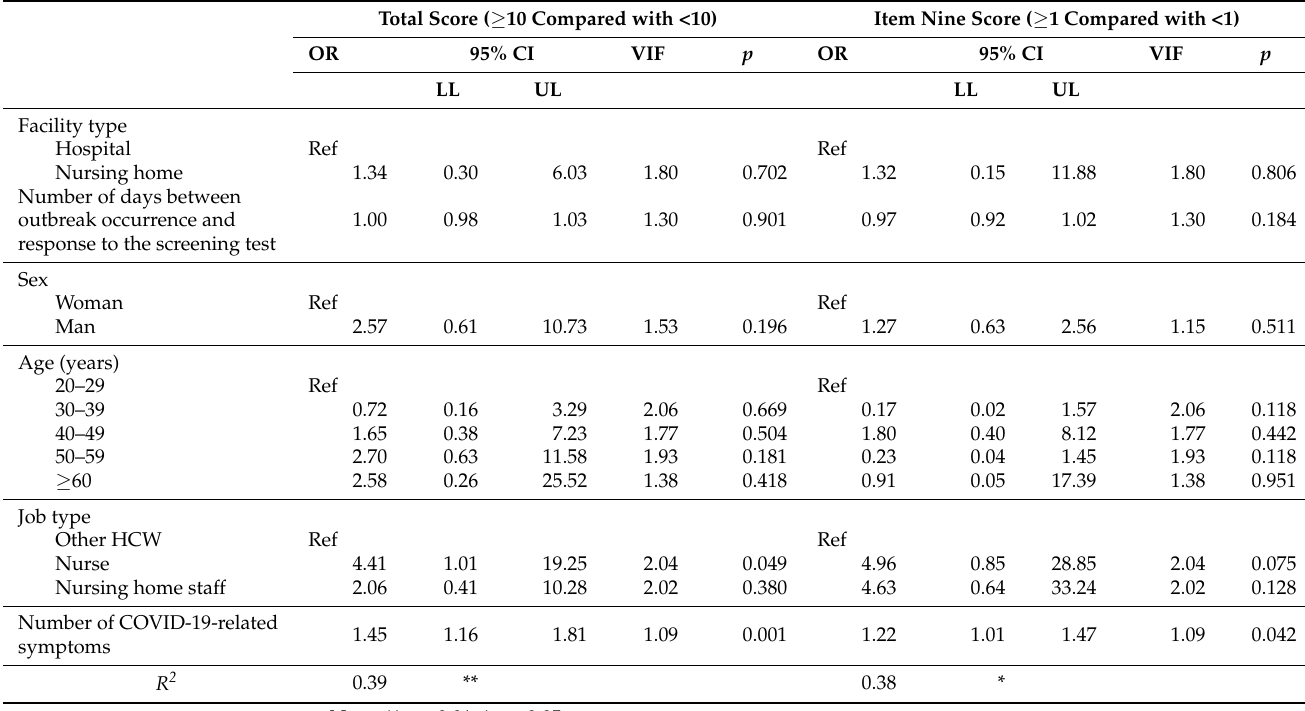
Table 5. Multiple logistic regression analysis for PHQ-9 in PCR-positive HCWs ( n = 79). Total Score ( ≥ 10 Compared with <10) Item Nine Score ( ≥ 1 Compared with